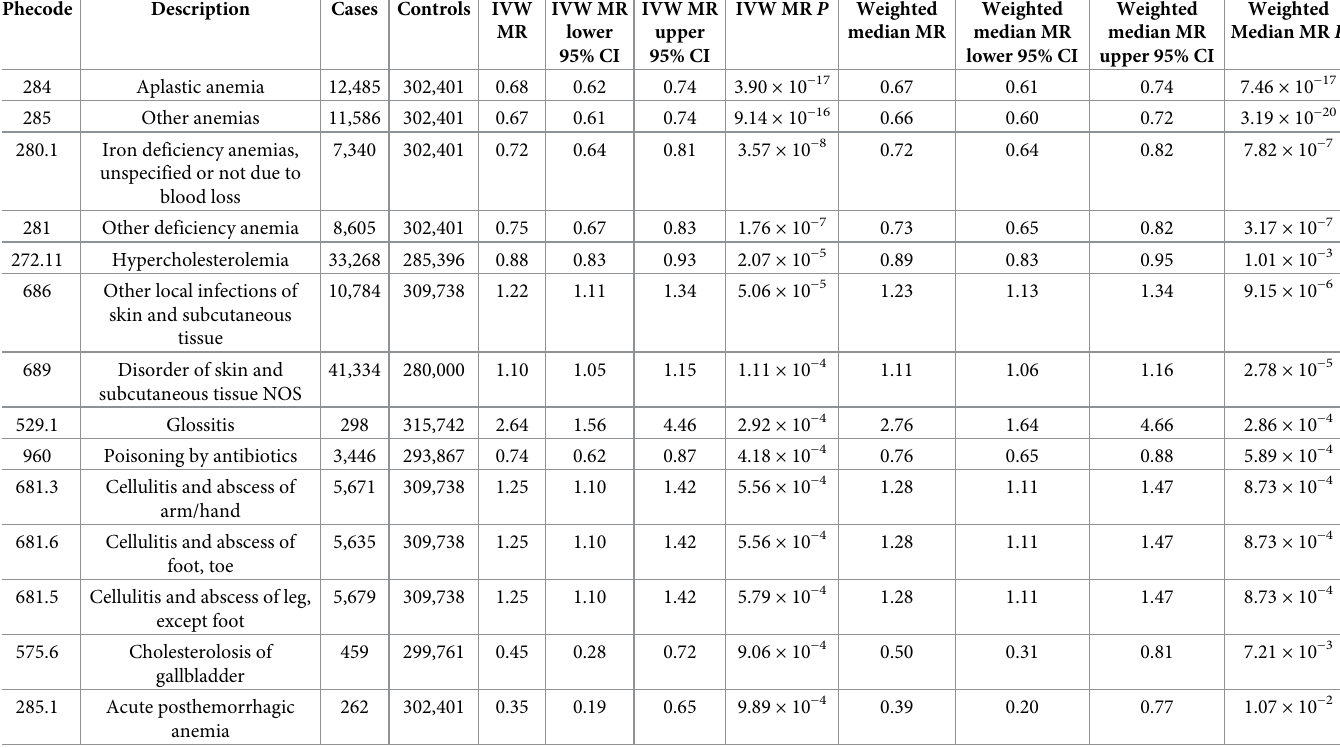
Table 3. IVW MR and weighted median MR estimates for the outcomes reaching 5% FDR significance where there was no evidence of heterogeneity as determined by the Cochran Q test.